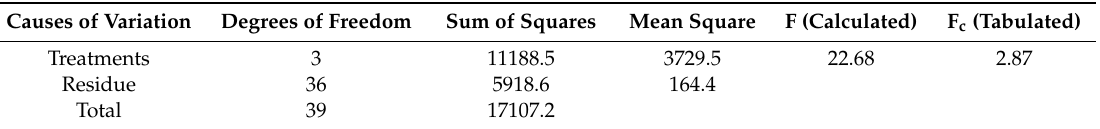
Table 2. Analysis of variance for the Izod impact energy of the neat epoxy resin and CM sedge fiber-reinforced composites.